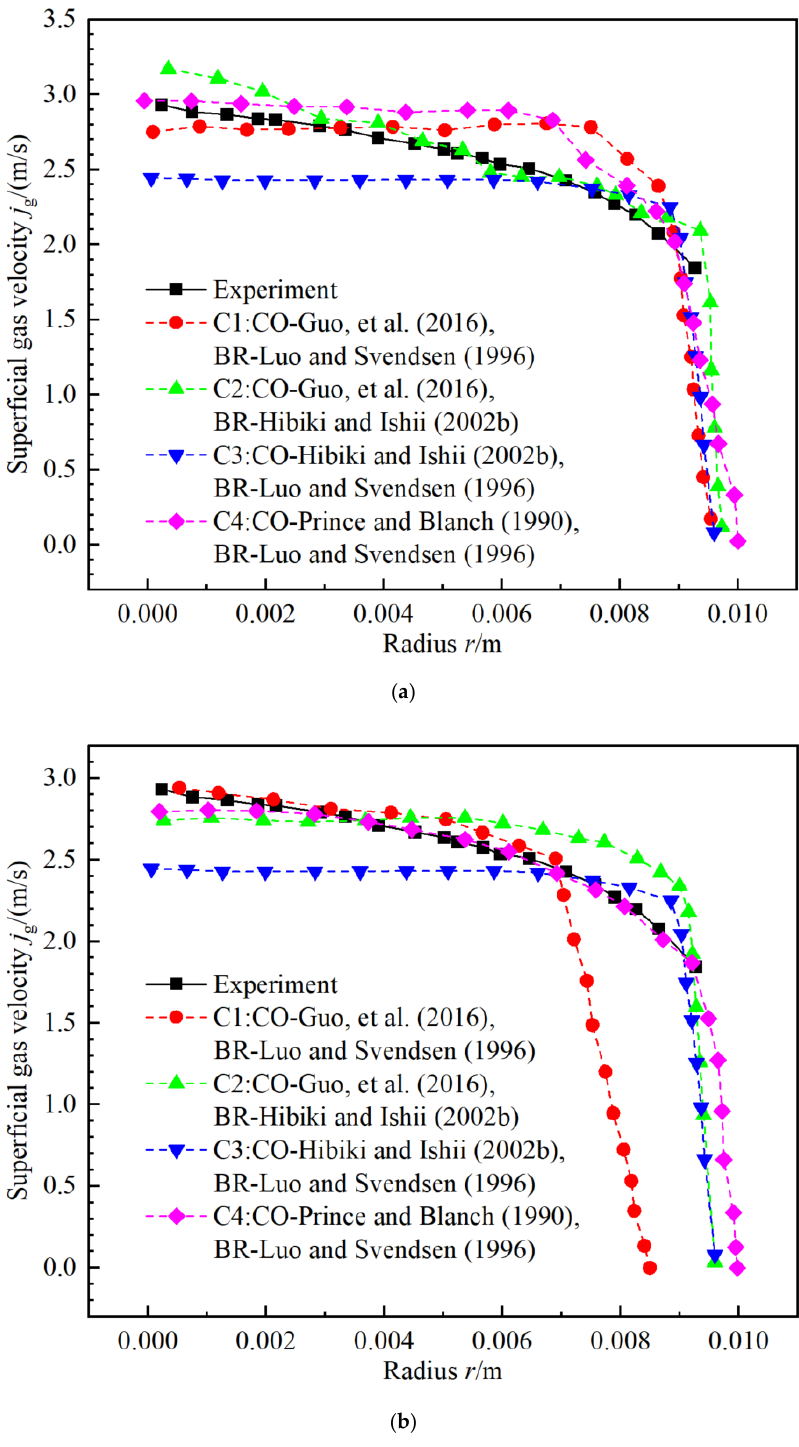
Figure 8. Superficial gas velocity j g distribution of various combinations of coalescence and breakup kernel with model of D d [8], f [46] and DEBORA-1 experiment ( P = 2.62 MPa) [28] at z = 3.5 m. ( a ) with Nn of Kocamustafaogullari and Ishii [36], and ( b ) with N n of Basu[40]. In Figure 8a, except the near wall region ( r > 8.5 mm), the relative errors between four combinations of C1, C2, C3, and C4 under the N n model of Kocamustafaogullari and Ishii